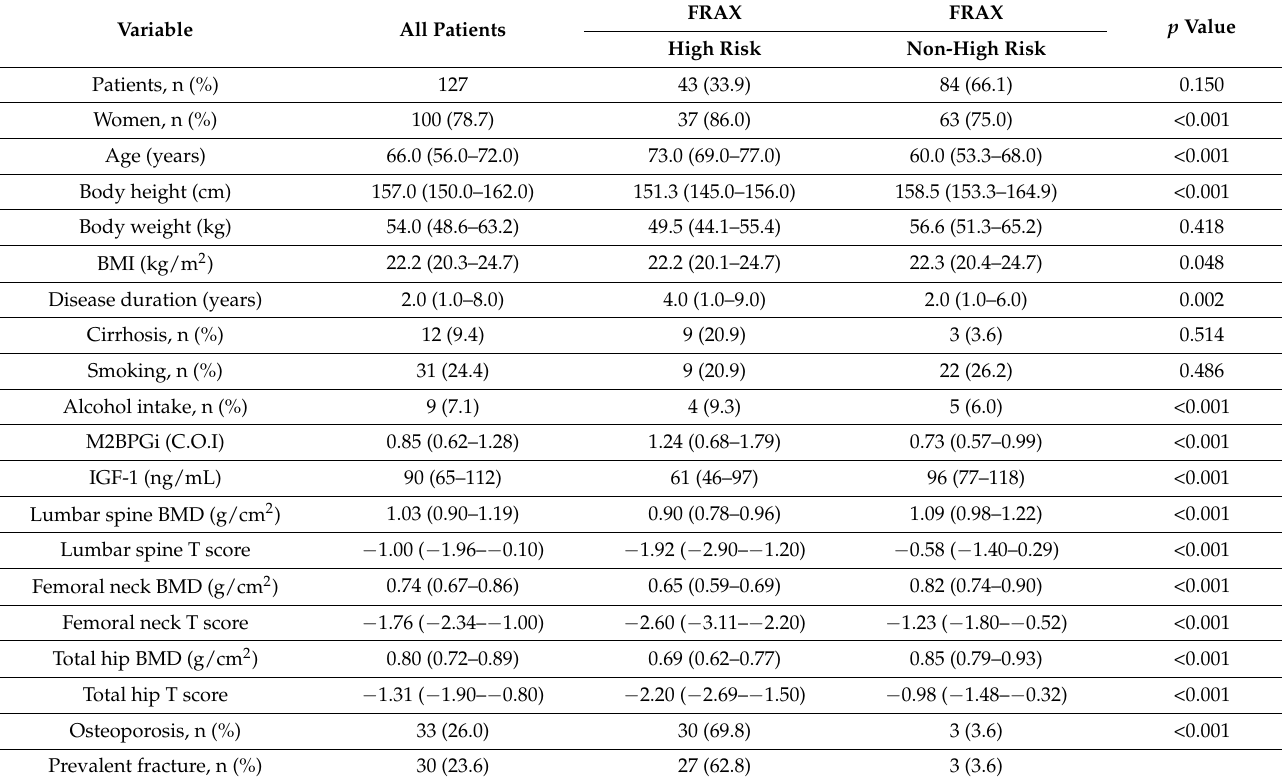
Table 1. Comparison of clinical characteristics between patients with and without high fracture risk based on the FRAX.